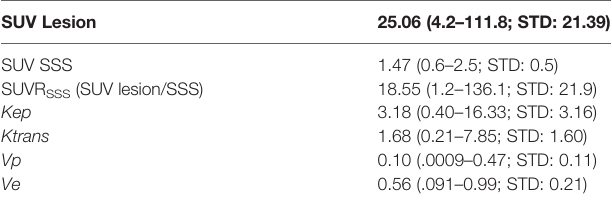
TABLE 2 | SUV and DCE parameters.